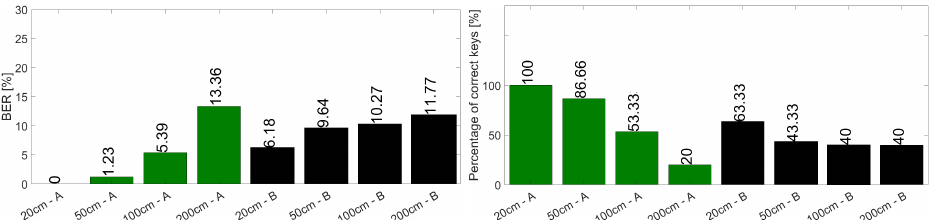
Figure 10. The BER ( left ) and the percentage of correct keys ( right ) for the 30 measurements with Motorola E6 (marked with green when receiver app running on Motorola E6) and Samsung S7 (marked with black when receiver app running on Samsung S7) at 20 cm, 50 cm, 100 cm and 200 cm.